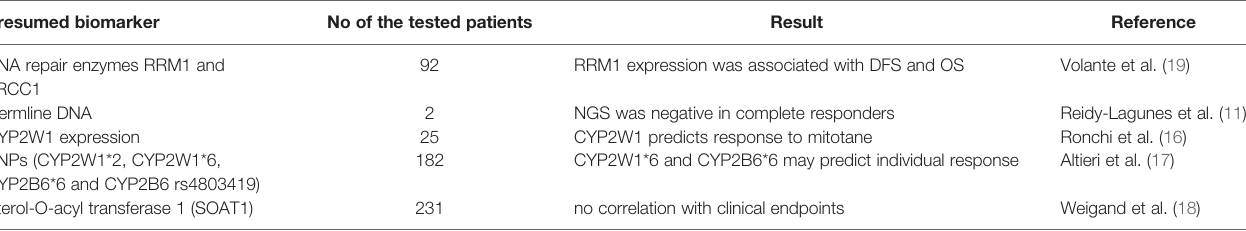
TABLE 1 | Molecular markers tested so far for a response to mitotane monotherapy in patients with advanced ACC. Presumed